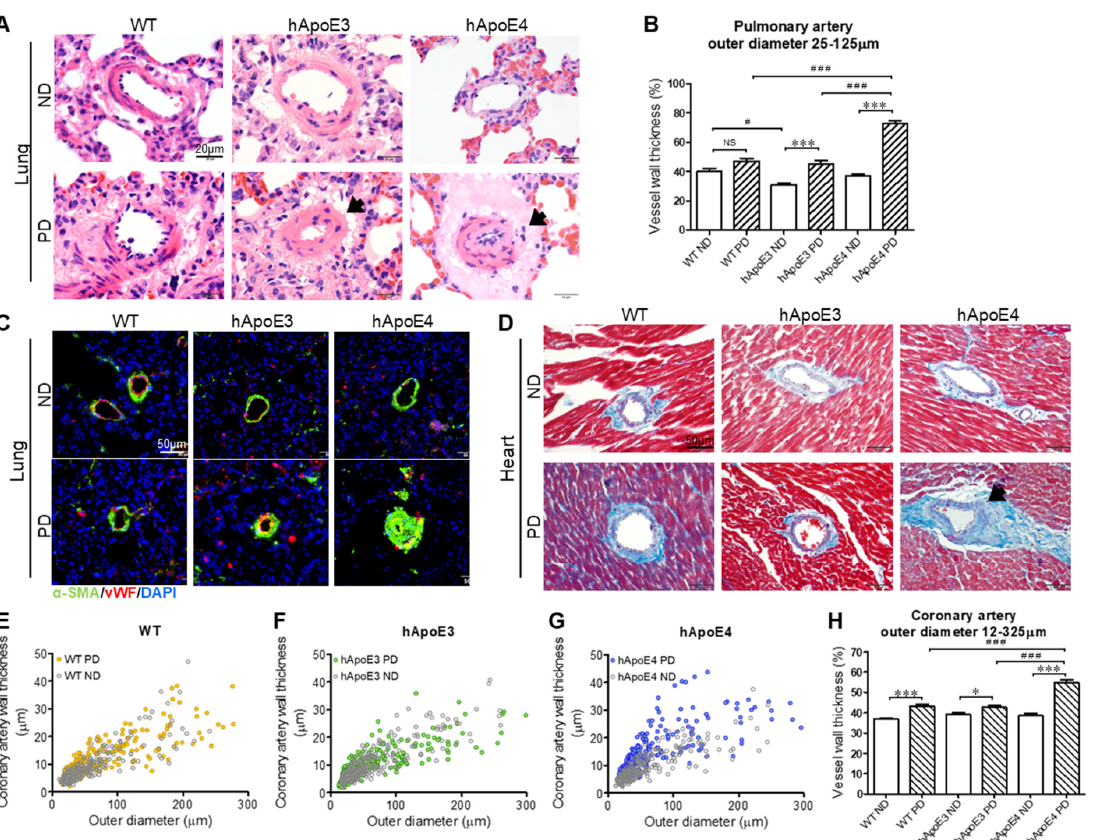
Figure 9. Vessel thickening of hApoE4 rats after PD. ( A ) HE-stained small arteries of rats fed with 4-month PD. The thickening of the small vessels is indicated with black arrows. ( B ) Statistical analysis of arterial wall thickness in lungs is shown. (n = 50–100 vessels from 9–11 rats for each group.) ( C ) The layers of vascular smooth muscle cells were stained by anti- α -SMA antibody. Endothelial cells were stained by anti-vWF antibody. Nuclei were stained by DAPI. ( D ) Masson-stained coronary arteries are shown. The thickening of coronary arteries is indicated by black arrow. Peri-coronary artery fibrosis was blue stained. ( E – G ) The thicknesses of coronary arteries with different outer diameters are compared between ND and PD groups. The arteries were imaged from the heart cross-sections at the papillary muscle level. H. Wall thickness of coronary arteries is compared between WT, hApoE3, and hApoE4 rats fed with 4-month ND or PD. (n = 250–350 vessels from 9–11 rats for each group. Two-way ANOVA followed by a Bonferroni post hoc test. * and # , p < 0.05; *** and ### , p < 0.001; NS, no significant difference).